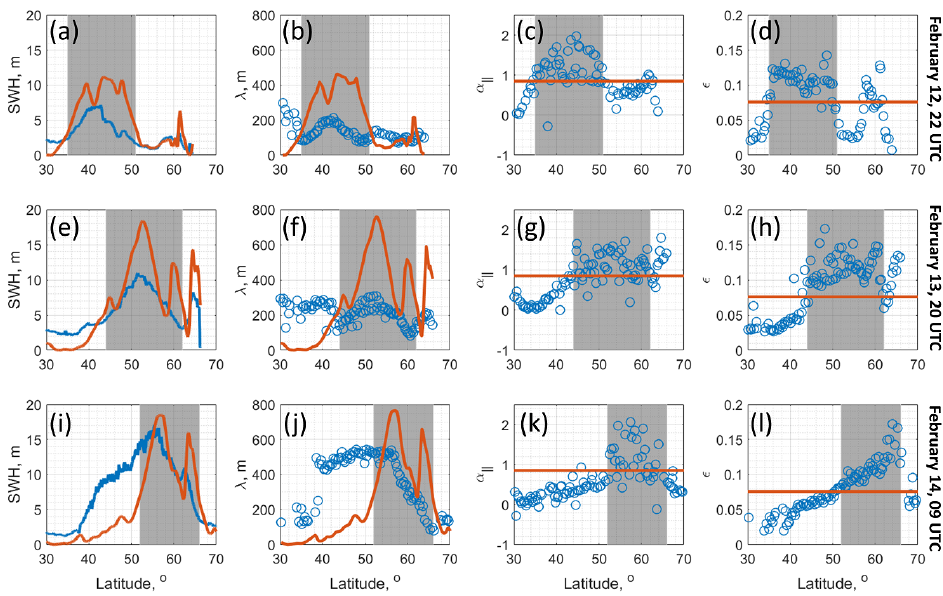
Figure 8. Along − track profile of ( a , e , i ) SWHs, H s ; ( b , f , j ) spectral peak wavelength, λ p ; ( c , g , k ) inverse wave age, α || = ( u / c p ) cos ( ϕ p − ϕ w ) ; and ( d , h , l ) wave steepens, (cid:101) = k p H s /2 with k p = 2 π / λ p . Blue circles and curves show the measurements, and the orange curves represent the values associated with fully developed waves. The average time of the SWIM passage over the North Atlantic Ocean is shown on the right side of each row. The SWIM nadir tracks can be found in 2nd, 8th and 10th rows of Figure